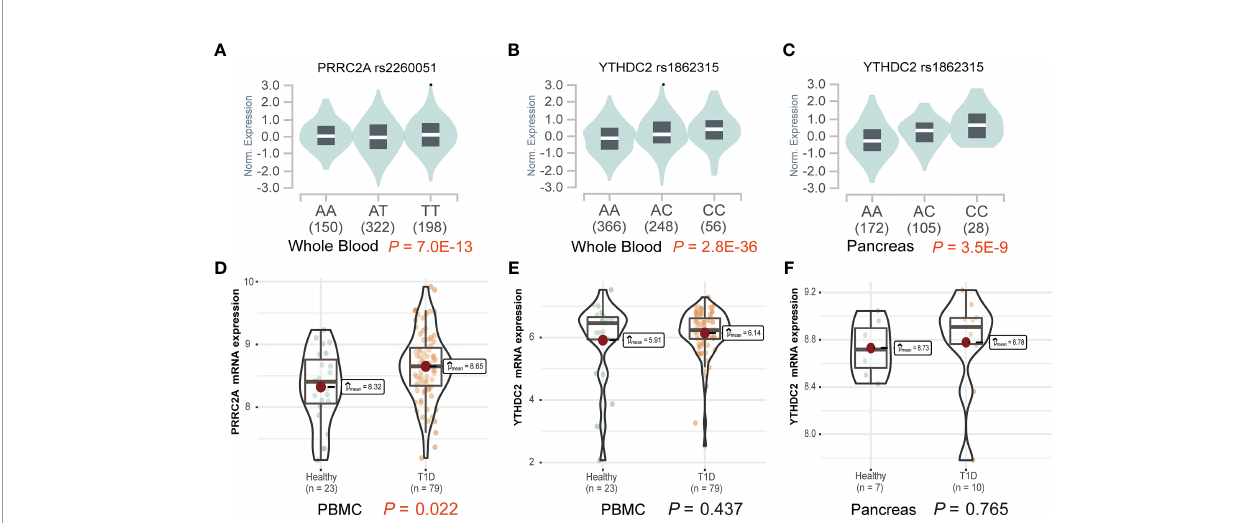
FIGURE 1 | Effects of variants on gene expression of PRRC2A and YTHDC2. (A) The effect allele of rs2260051 was signi fi cantly associated with increased expression of PRRC2A in whole blood samples. The minor allele of rs1862315 was signi fi cantly associated with increased expression of YTHDC2 in (B) whole blood and (C) pancreas. (D) The expression levels of PRRC2A mRNA were signi fi cantly higher in the peripheral blood mononuclear cell (PBMC) samples from type 1 diabetes (T1D) than the healthy control. No signi fi cant differences in YTHDC2 between T1D and healthy control from (E) PBMC or (F) pancreatic samples.